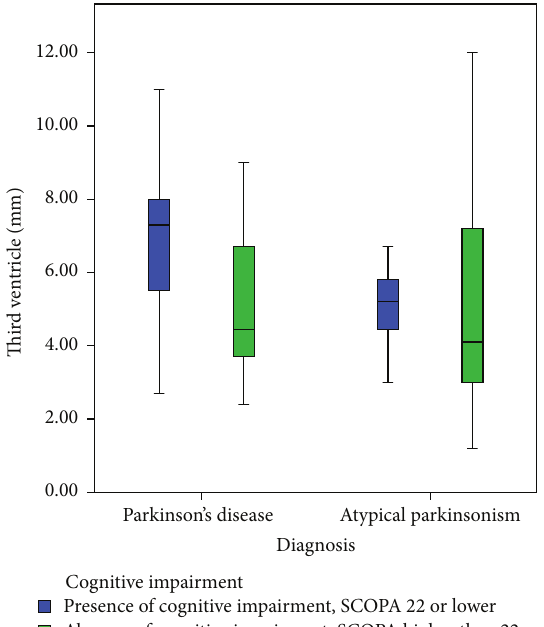
Figure 4: Boxplot of the range of scores on the SCOPA-COG scores comparedtothediameterofthethirdventricledividedinsubgroups with and without cognitive